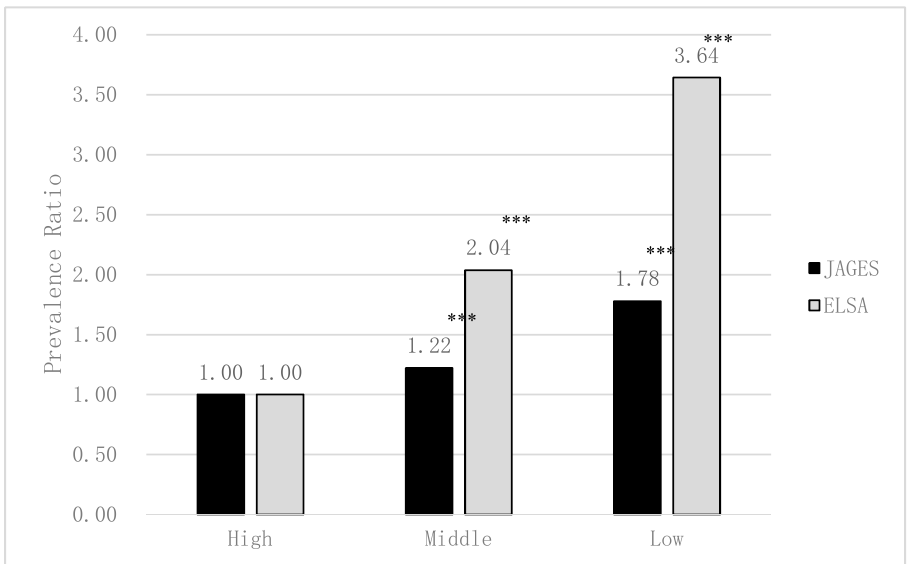
Figure 3. The association between edentulism and educational attainment in Japan and England estimated by Poisson regression analyses (adjusted for sex and age; JAGES N = 79,707, ELSA N = 5115). *** p < 0.001. Table 2. Absolute and relative socioeconomic inequalities of edentulousness in JAGES and ELSA.